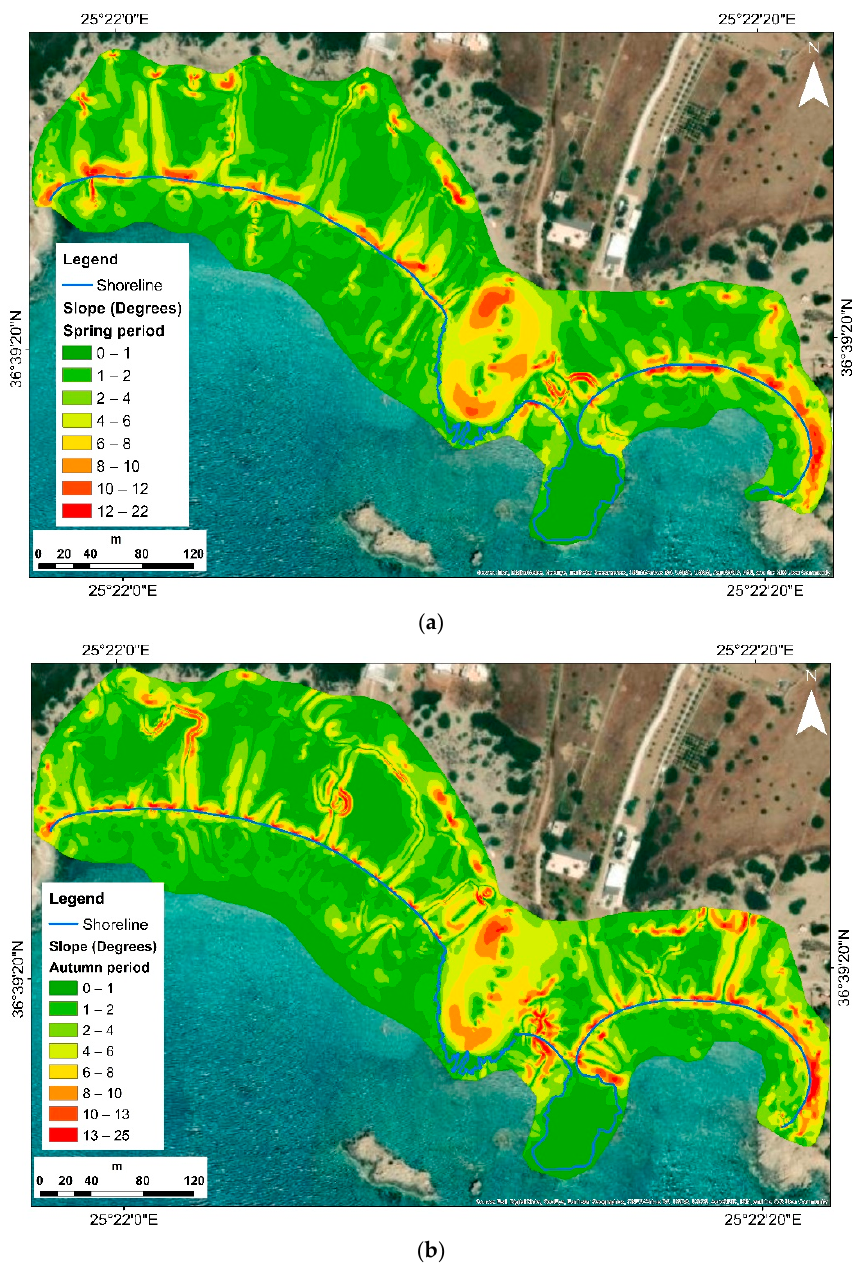
Figure 12. Map of morphological slopes of Magganari beach. ( a ) Shows the slope values from seaward to landward for the autumn period. ( b ) Shows the slope values from seaward to landward for the spring period.